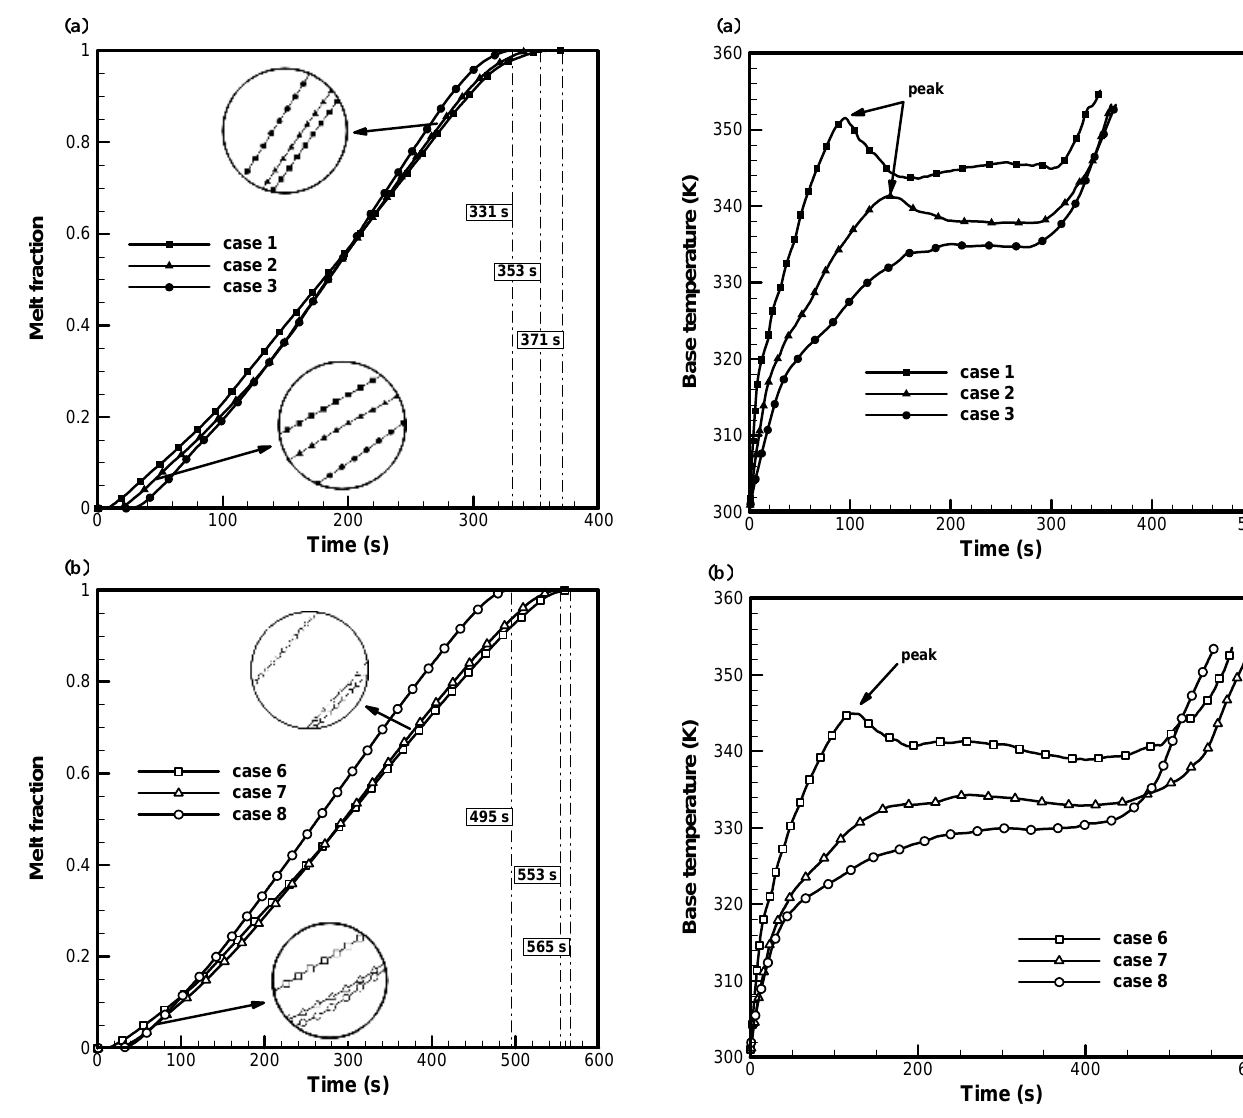
Figure 7. Base temperature evolution with time for different fin thicknesses: (a) various cases for fin height of 15mm and (b) vari- ous cases for fin height of